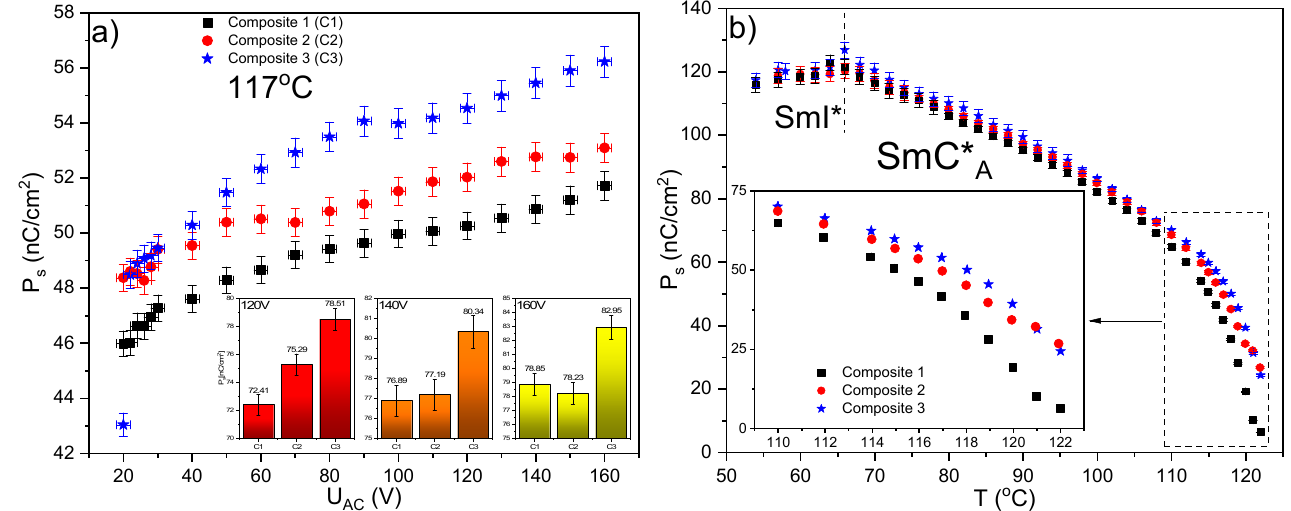
Figure 13. Spontaneous polarization versus applied voltage, T = 117 °C, f = 50Hz ( a ). The inset shows the P s bar graphs for the selected amplitudes at T = 105 °C, f = 50Hz. Temperature dependence of the spontaneous polarization in the SmC* A and SmI* phases for all Composites ( b ). An enlarged high temperature range is presented in the inset, Δ U AC = ±2V, Δ P s = 1%.